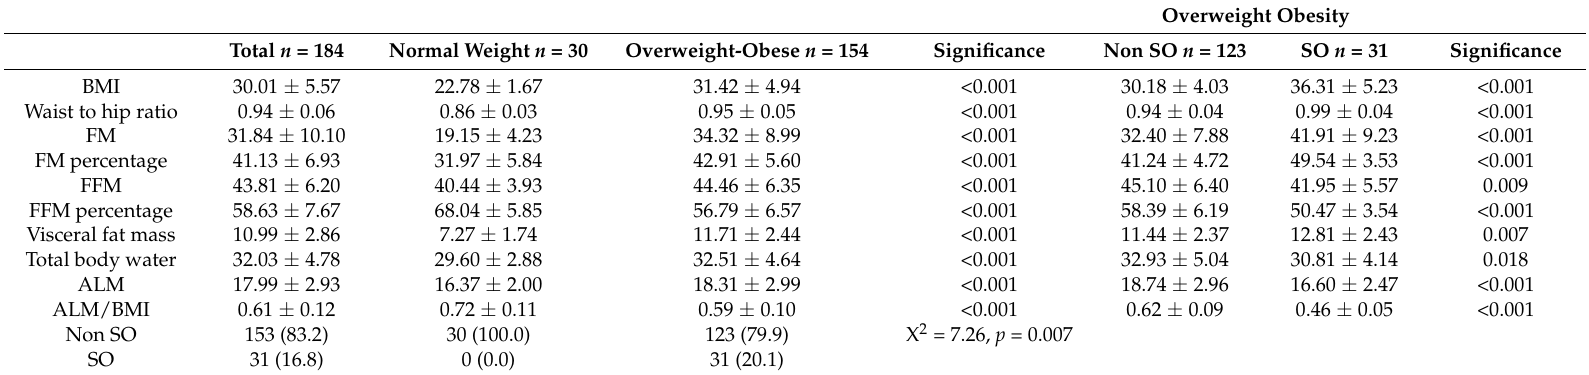
Table 2. Anthropometric characteristics and body composition patterns in normal-weight participants and overweight and obese patients, categorized with or without sarcopenic obesity.